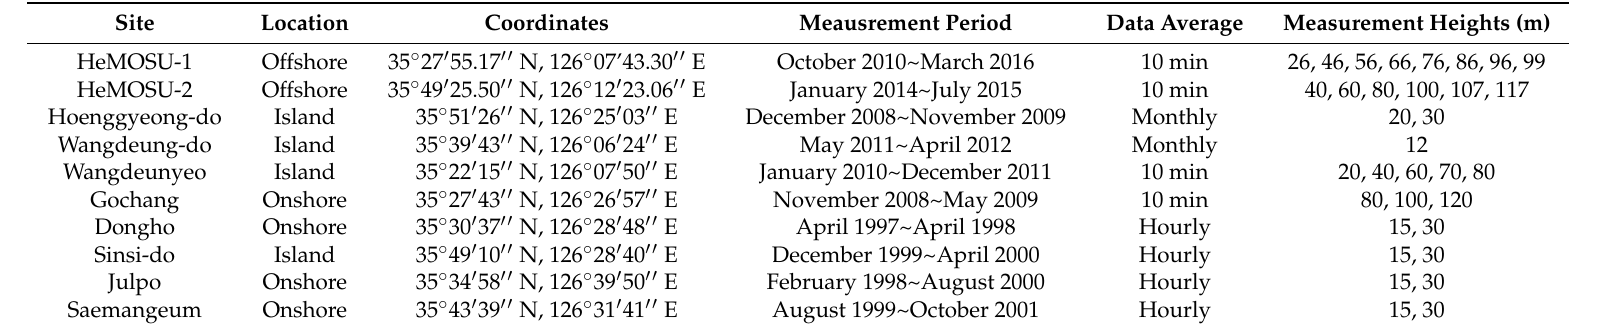
Table 2. Summary of the meteorological tower